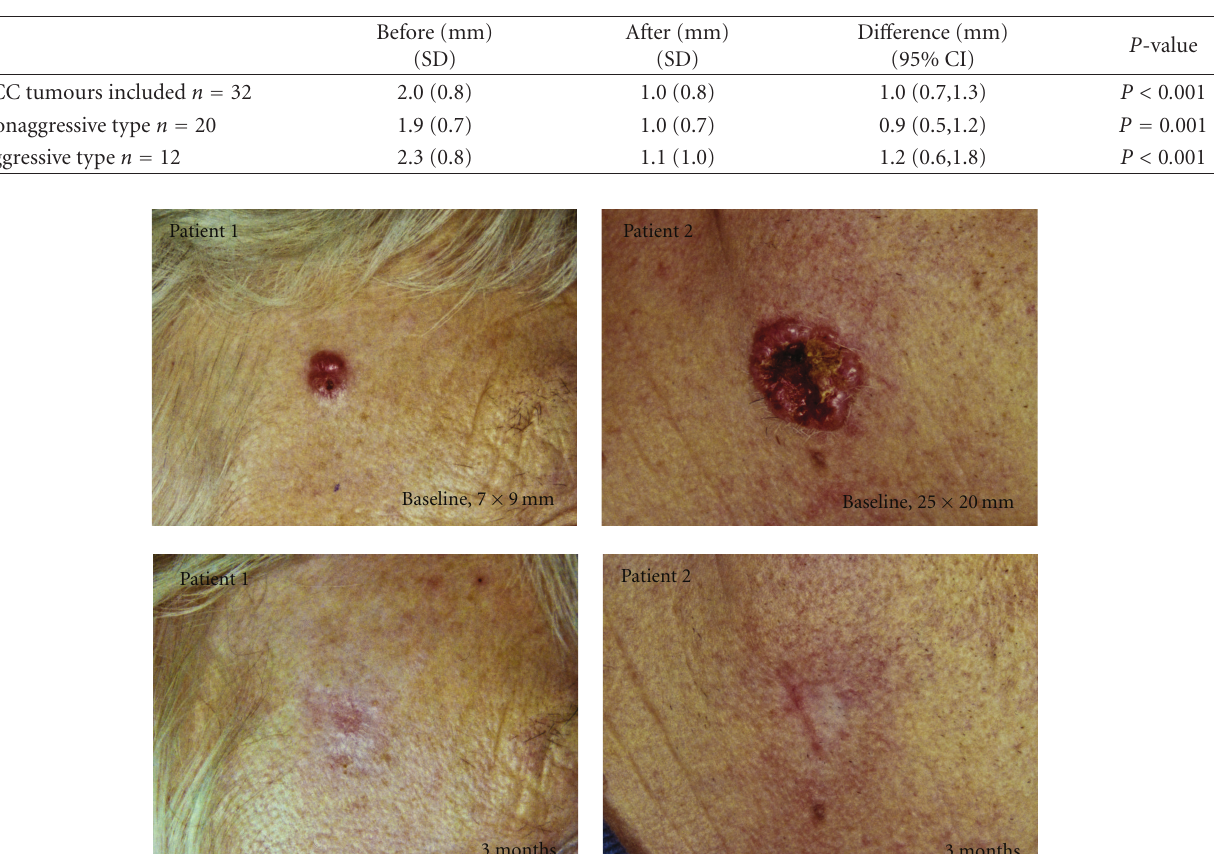
Table 1: Mean BCC tumour thickness measurements, before and after curettage.